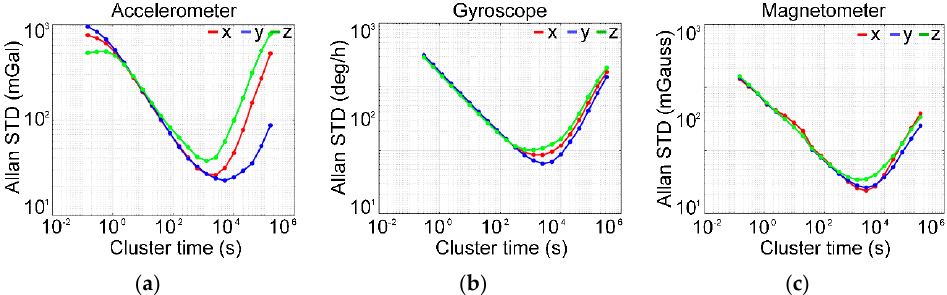
Figure 10. Allan standard deviation (STD) value of accelerometer ( a ), gyroscope ( b ), and magnetometer ( c ) data.